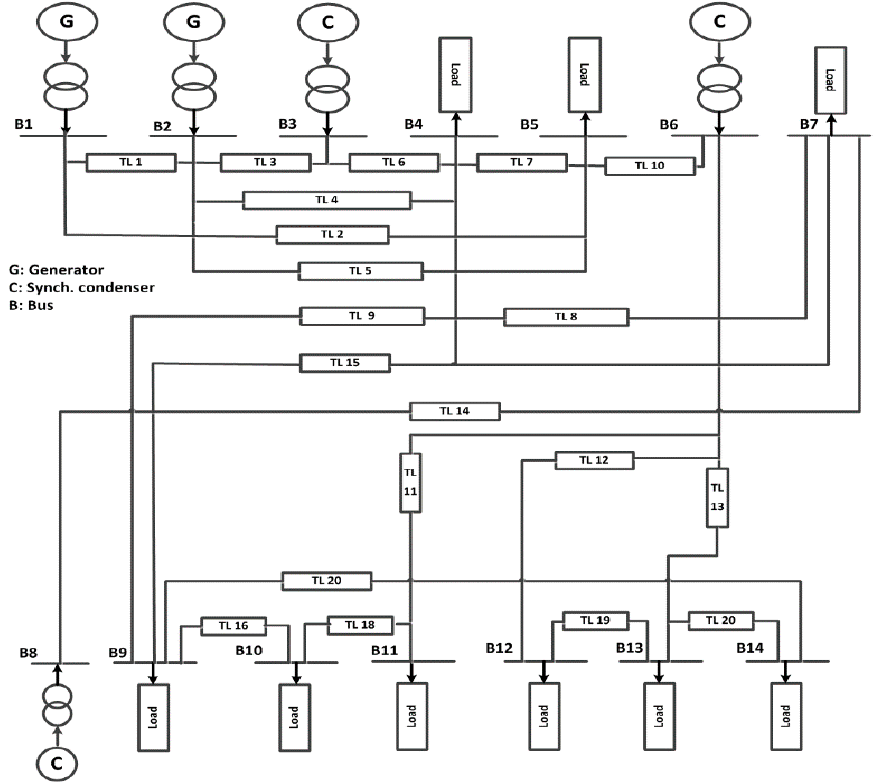
Figure 7. IEEE 14-bus system used in case study-3.